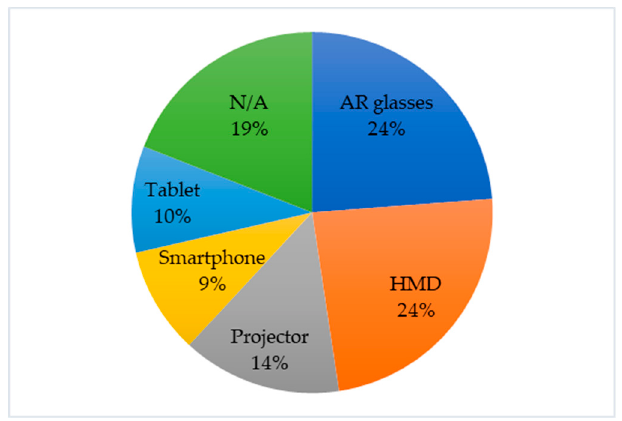
Figure 13. Distribution of works related to AR visualization device.